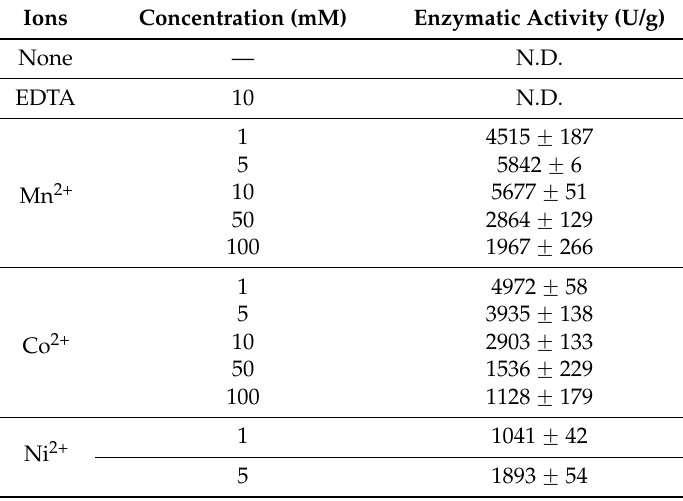
Table 1. Effect of metal ions on the activity of purified pfGDPD.